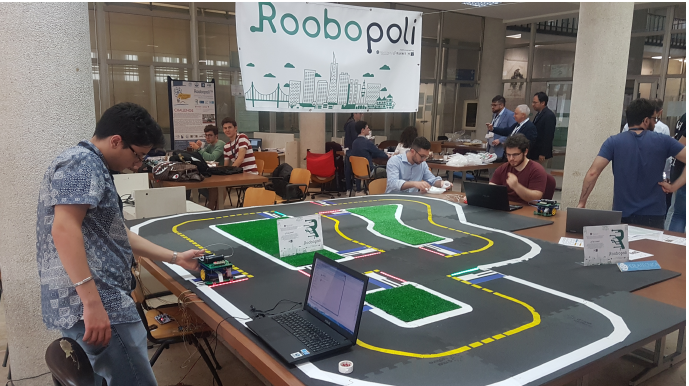
Figure 4. A Roobopoli workshop including the Roobopoli city and